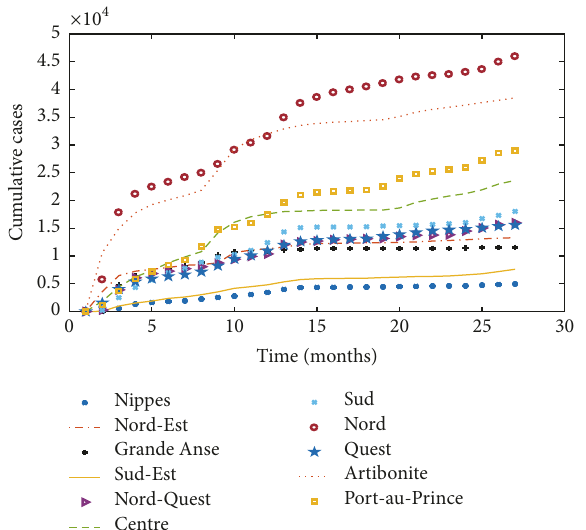
Figure 3: A plot showing the cumulative reported hospitalized cholera cases in each department in Haiti from October 30, 2010, to December 24, 2012. The legend is in order of population size (Nippes = 311497, Nord-Est = 358277, Grande Anse = 425878, Sud- Est = 575293, Nord-Quest = 662777, Centre=678626, Sud = 704760, Nord=970495, Quest = 1187833, Artibonite = 1571020, and Port-au- Prince = 2476787).